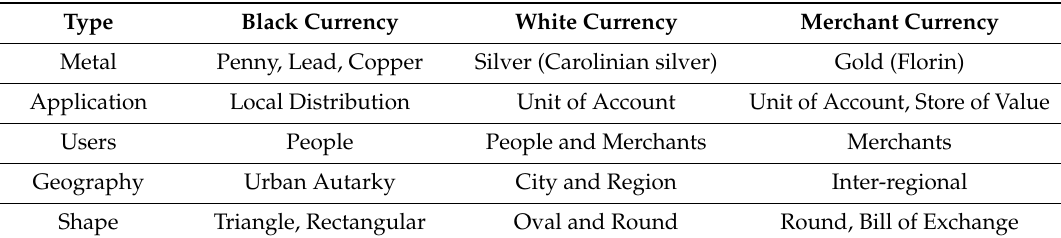
Table 1. Trimetallic pre-Renaissance